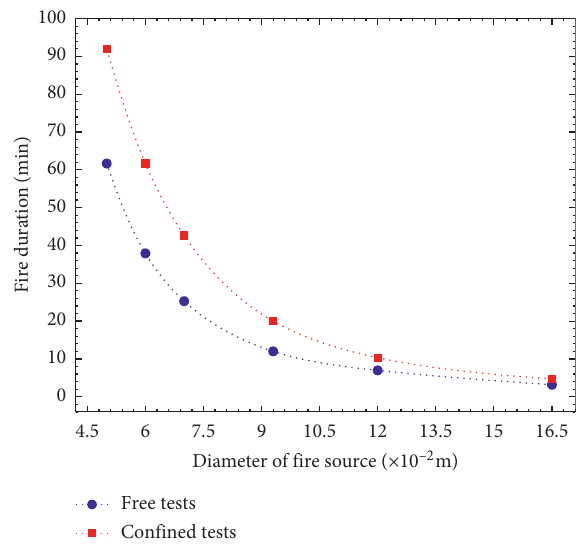
Figure 13: Variation of the duration of fire in opened and confined